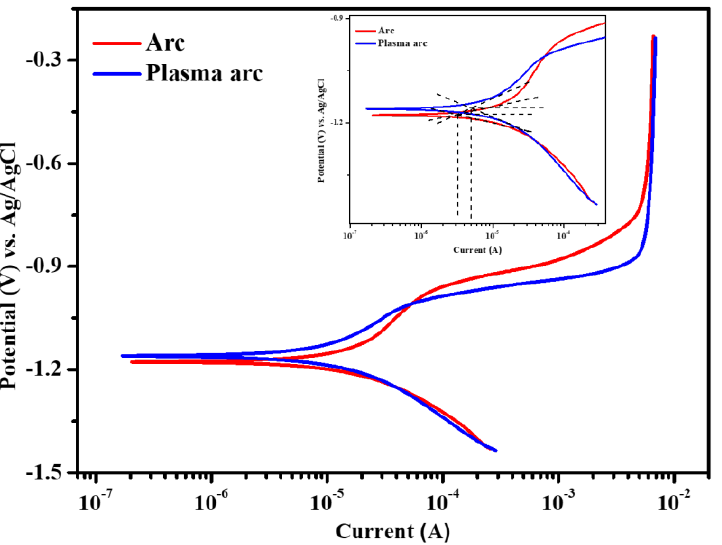
Figure 10. Potentiodynamic polarization plots of the Zn coatings deposited by the arc thermal and plasma arc thermal processes after 23 d of exposure to artificial seawater. Table 5. Electrochemical parameters obtained after the fitting of potentiodynamic polarization plots in the Tafel slopes.